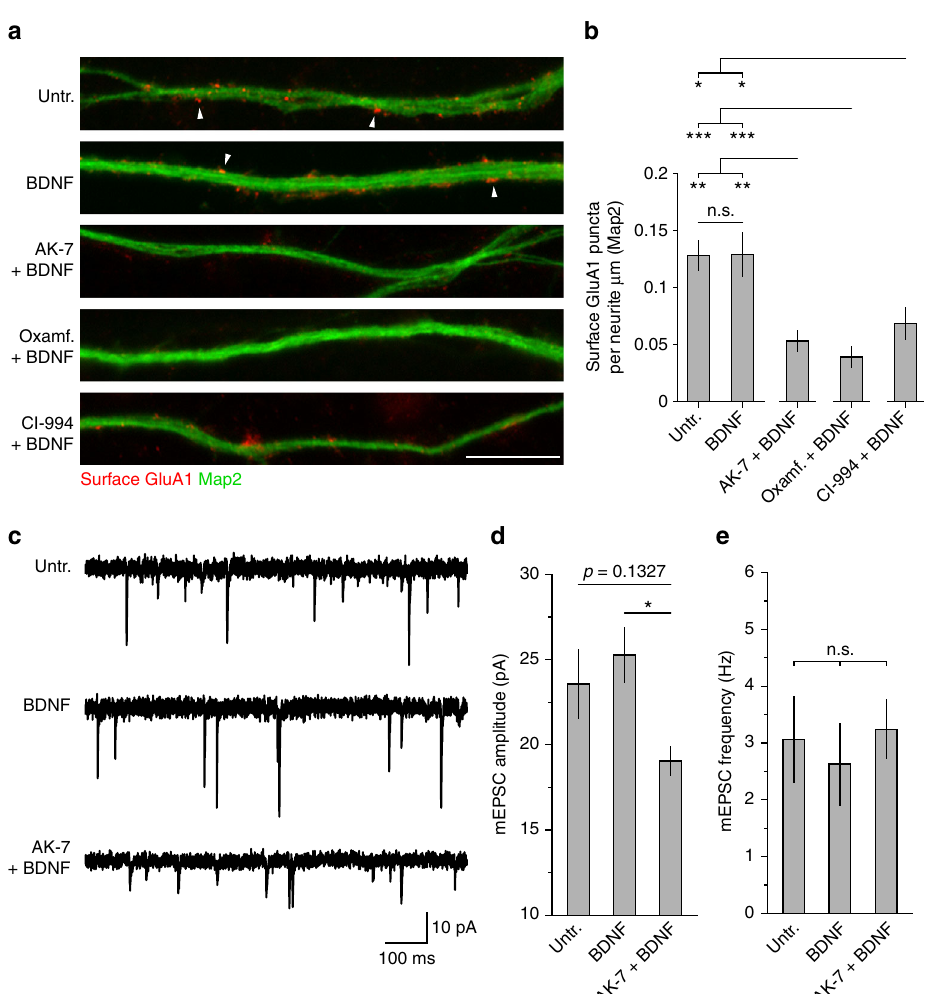
Fig. 8 Effects of KDAC inhibitors AK-7, oxam fl atin, and CI-994 on AMPAR biology. a Representative images of surface GluA1 immunostaining in DIV14 mouse primary cortical neurons for each tested experimental condition. AK-7, oxam fl atin, or CI-994 was applied at a fi nal concentration of 16.7 µ M and treatment duration was 6 h with BDNF. Scale bar 10 µ m. b Graph shows mean number of surface GluA1 puncta per dendrite µ m for cells treated as in a . Separate ANOVA revealed a signi fi cant difference between cells co-treated with a KDAC inhibitor and BDNF over untreated and BDNF alone conditions (AK-7, F 2,72 = 7.28, p < 0.005; oxam fl atin, F 2,72 = 10.37, p < 0.0005; CI-994, F 2,72 = 4.25, p < 0.05). Tukey ’ s HSD post hoc test, * p < 0.05; ** p < 0.01; *** p < 0.005. c Representative traces of mEPSCs from DIV15 mouse primary cortical neurons treated according to the indicated treatment (untreated, BDNF alone, or AK-7 plus BDNF). Cells that were co-treated with AK-7 and BDNF for 6 h prior to recording show lower mEPSC amplitude. d Quanti fi cation of mEPSC amplitude for experimental conditions shown in c . One-way ANOVA revealed a signi fi cant difference in mEPSC amplitude between the BDNF alone and AK-7 plus BDNF condition ( F 2,22 = 3.89, p < 0.05). Tukey ’ s HSD post hoc test, * p < 0.05. A total of 5086 (untreated, n = 9 cells), 3760 (BDNF alone, n = 8 cells), and 4475 (AK-7 plus BDNF, n = 8 cells) mEPSC events were analyzed from three independent cultures. e Quanti fi cation of mEPSCs frequency shows no differences between experimental